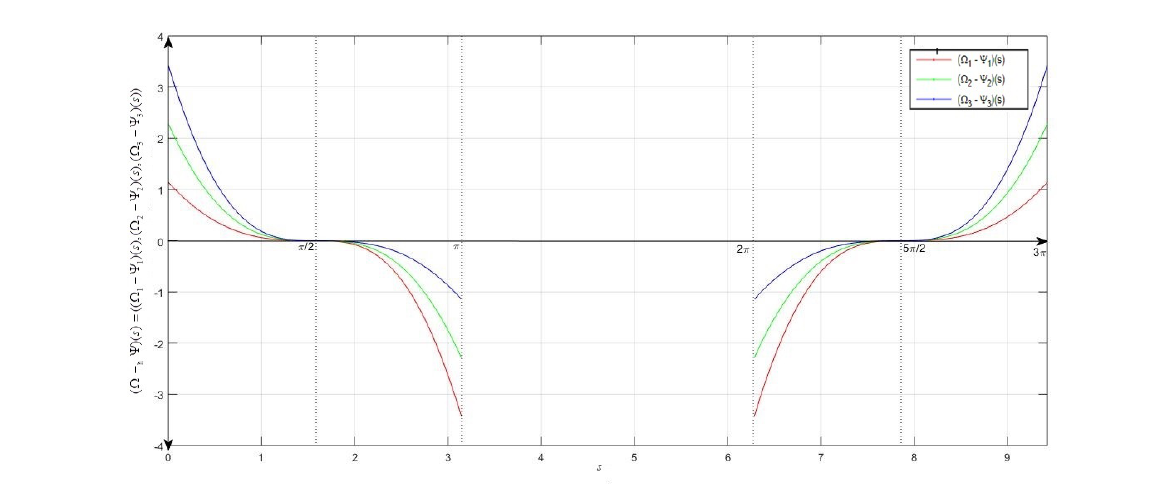
Figure 5. Graphical Representation of ( Ω ⊕ Ψ )( s ) in Example 3.